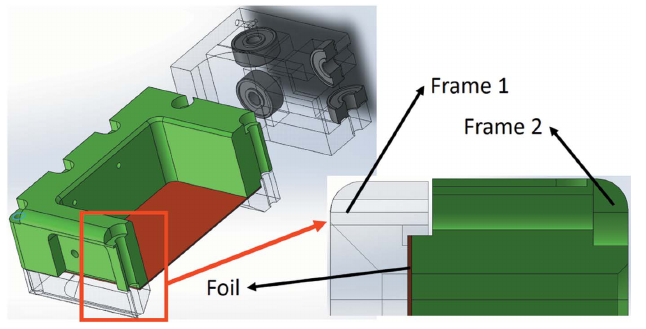
Figure 9 Diagram of the frame and foil clamp.